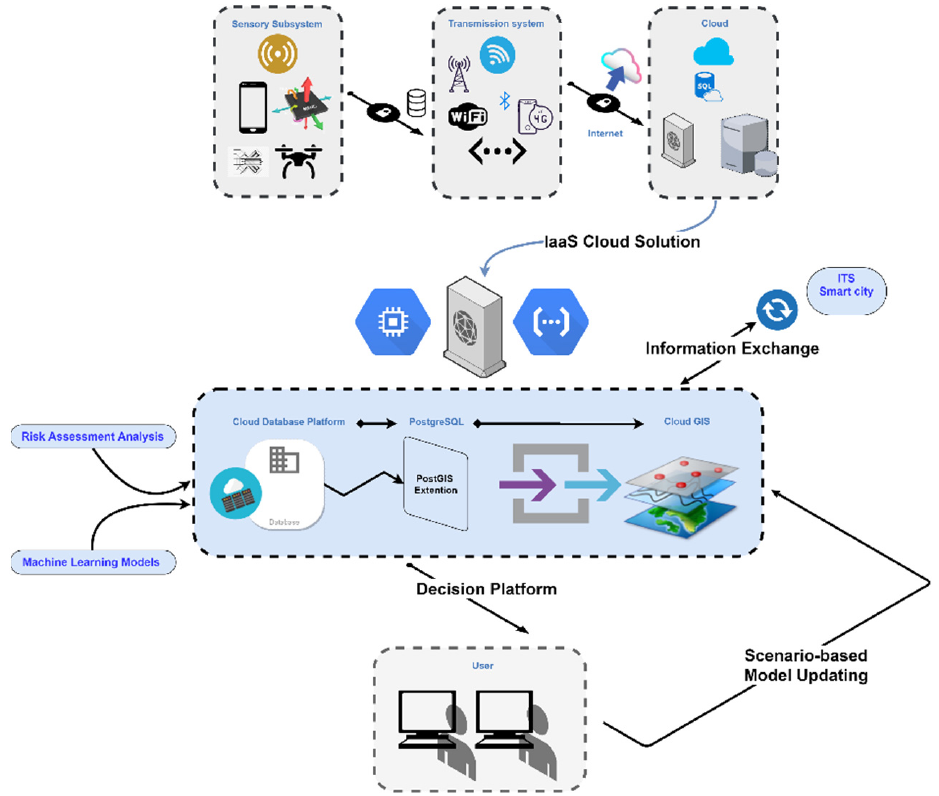
Figure 17. The system architecture of a cloud-based SHM-GIS decision-making system for bridge monitoring applications, modified from [69].